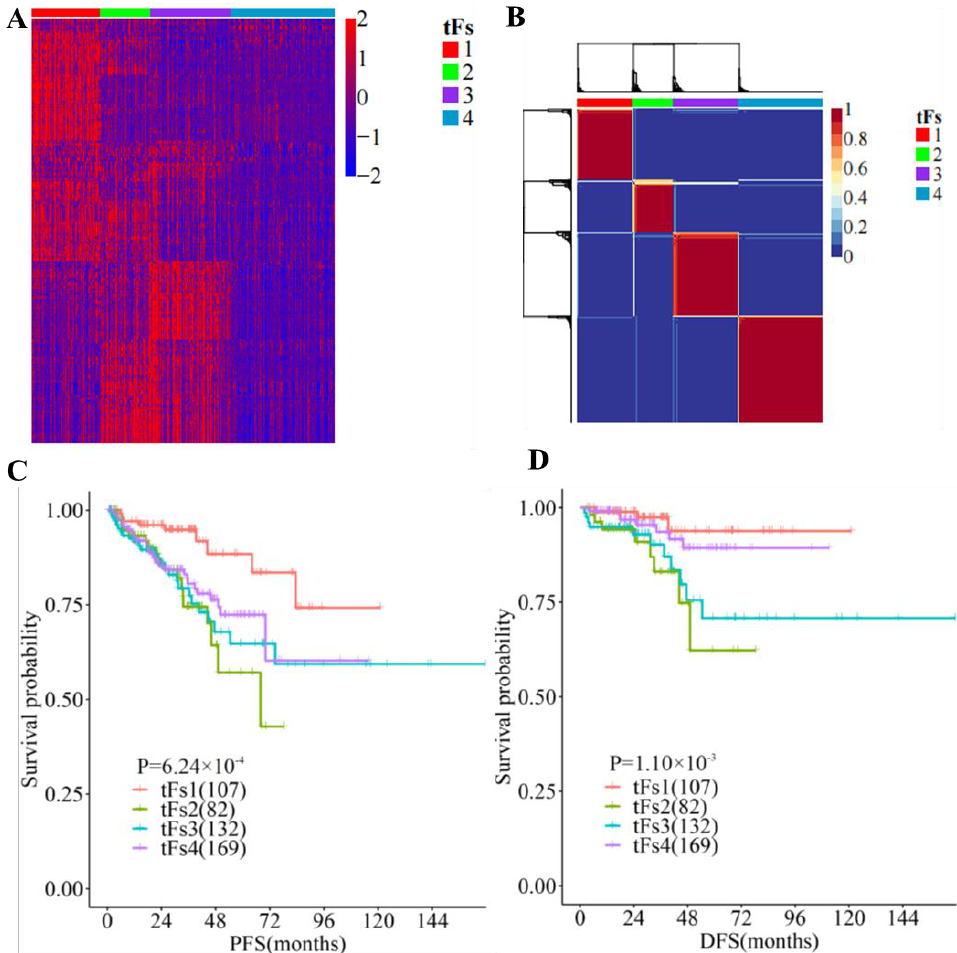
Figure 5. Expression of tRFs is a clinical biomarker for tumor classification in PRAD. ( A ) Analyses of 5ʹ -tRFs in PRAD samples yielded four stable subgroups using a non-negative matrix factorization (NMF) approach. ( B ) Tumors were clustered into four subtypes according to 5ʹ -tRF expression profiles. ( C , D ) Kaplan–Meier survival analysis of PFS ( C ) and DFS ( D ), showing significant prognostic differences among 5ʹ -tRFs expression subtypes.